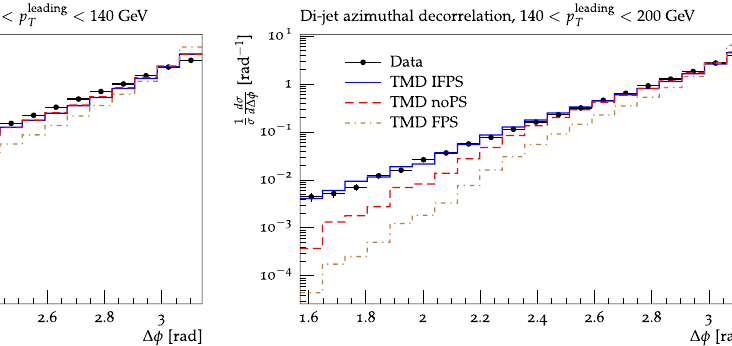
Fig. 5 (cid:4)φ distribution for high p t dijet production [43]. The solid (blue) histogram shows the prediction using off-shell 2 → 2 matrix elements with TMD parton densities, the dashed (red) line is a 3-parton configuration obtained with Powheg . Both predictions are without parton shower and hadronization